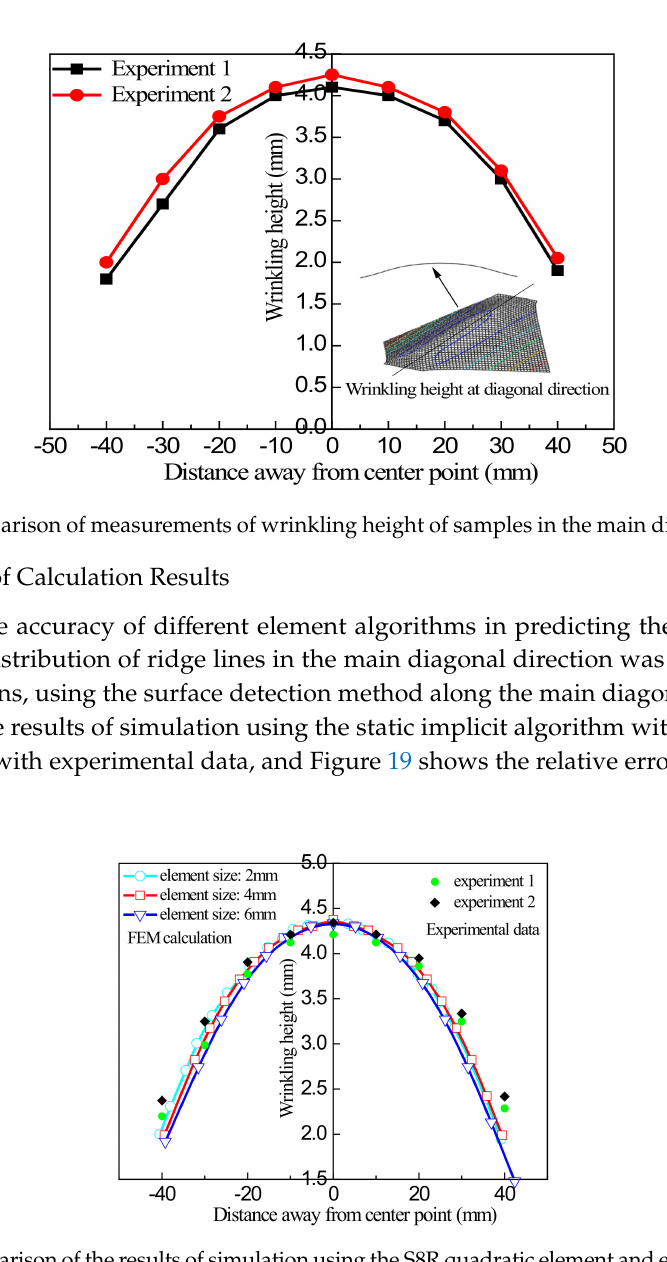
Figure 18. Comparison of the results of simulation using the S8R quadratic element and experimental data.